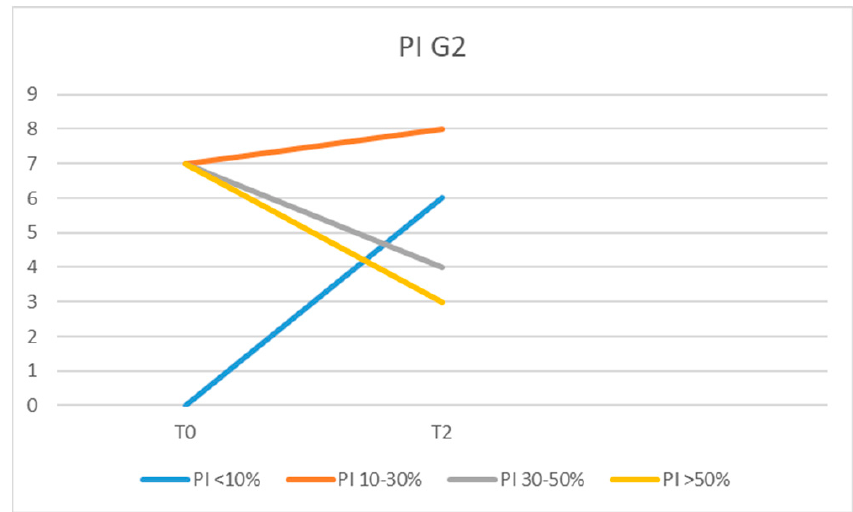
Figure 3. PI values in G2 at moments T0 and T2 .